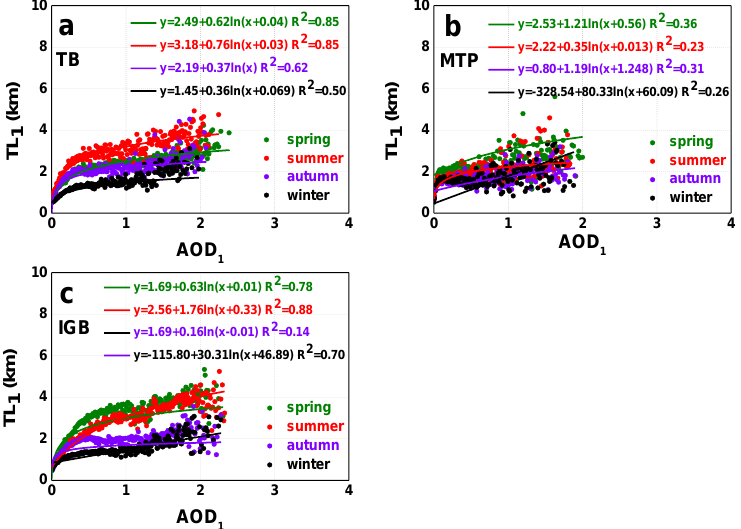
Figure 10. The correlations between AOD1 and the lowest aerosol layer thickness (TL1) over TP. ( a ) is for TB, ( b ) for MTP, and ( c ) for IGB.